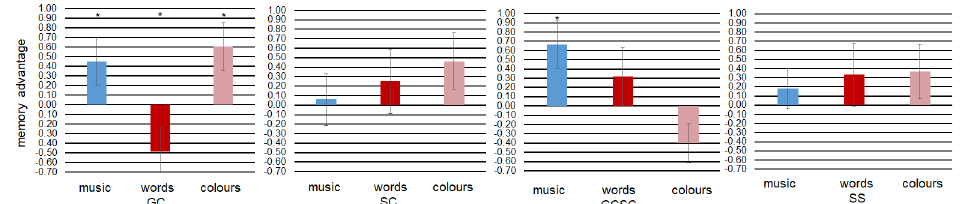
Fig 3. Difference of z-transformed recognition (Pr) of synaesthetes and controls. Sound-colour- and sequence- space synaesthetes show a general advantage. Grapheme-colour-and-sound-colour synaesthetes show an inducer- specific advantage. Grapheme-colour synaesthetes show rather a concurrent-related advantage. GC = Grapheme- colour synaesthetes; SC = Sound-colour synaesthetes; GCSC = Grapheme-and-Sound-colour synaesthetes; SS = Sequence-Space synaesthetes. Error bars display standard errors.